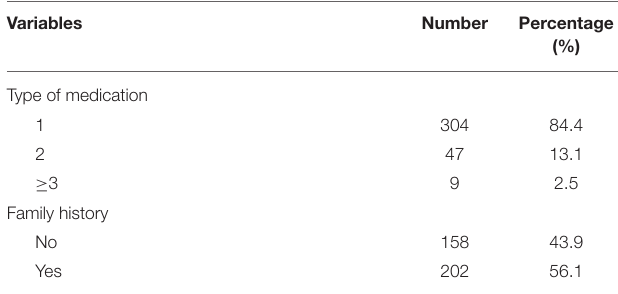
TABLE 6 | Sociodemographic and clinical characteristics of participants ( N =